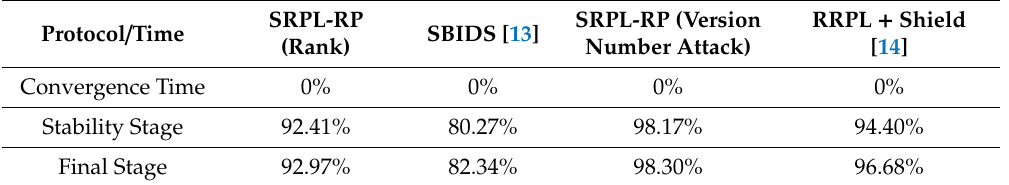
Table 14. Accuracy Rate (AR) Comparison Random